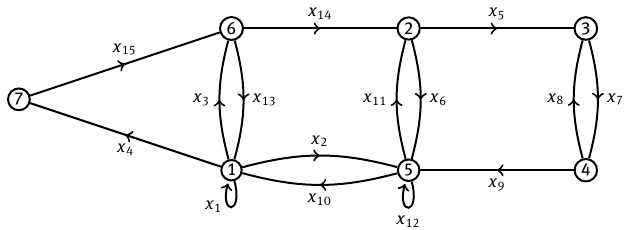
Figure 1: Weighted digraph for the pattern A of Example